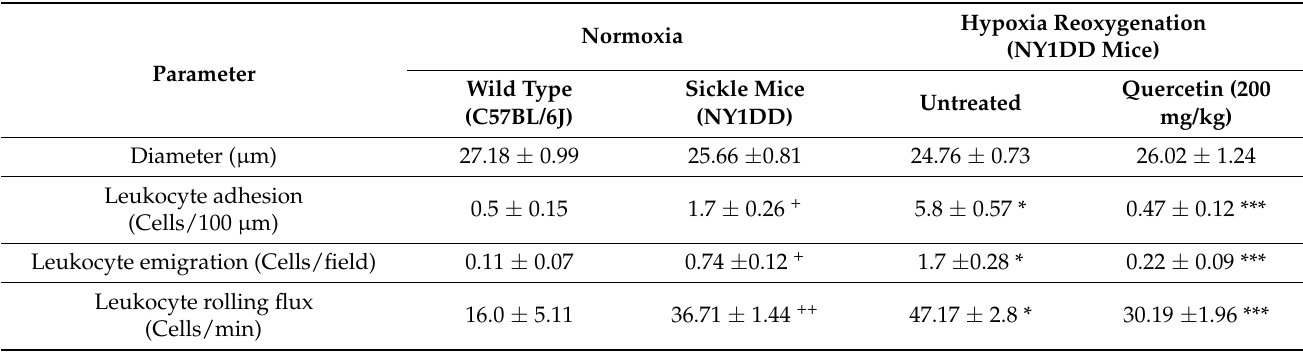
Table 1. Effect of a single dose of quercetin (200 mg/kg, i.p.) on venular diameter, leukocyte adhesion,